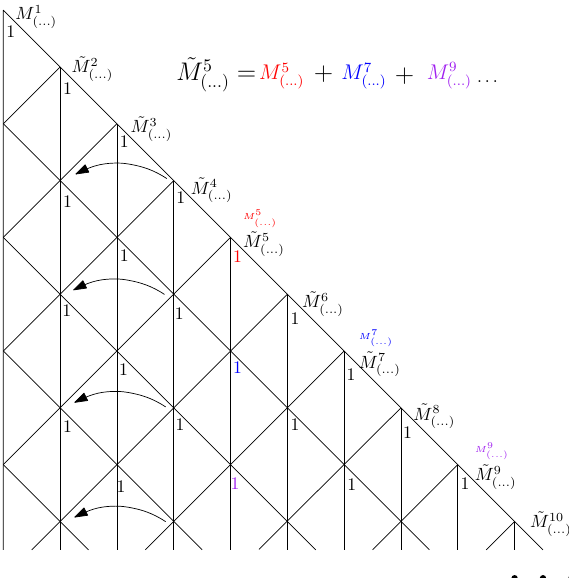
Figure 12. In each strip, triangles with coefficients correspond to terms in Formula (32). Each term is given by the multiplicity of a strip in the auxiliary lattice path model, situated to the far right of the considered triangle. As an example, we show how this mnemonic rule works for ˜ M 5